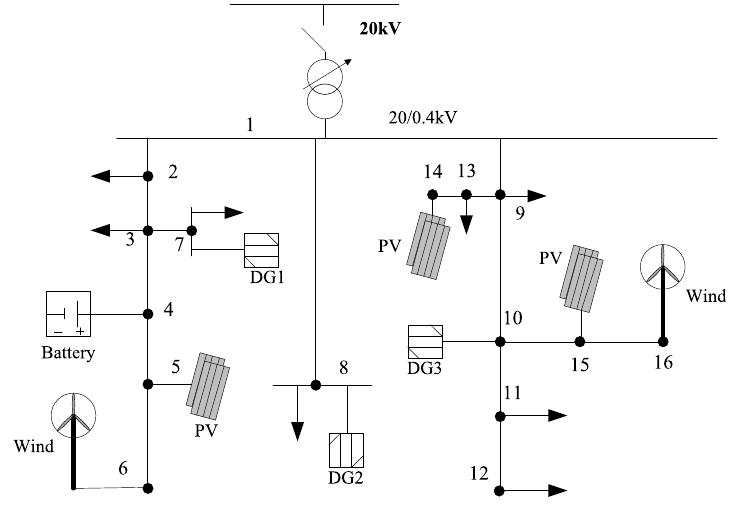
Figure 3. The low voltage MG for case study. Table 1. Data used for